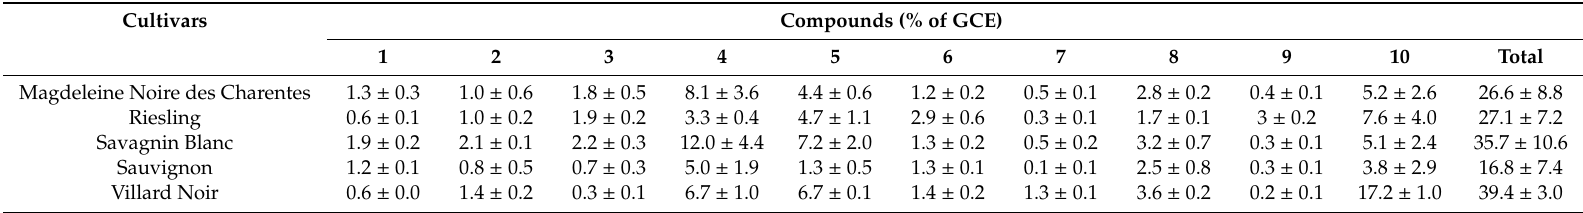
Table 1. Concentration of major polyphenols contained in grape cane extracts (GCE) from selected cultivars (% of dry GCE). (1) catechin, (2) epicatechin, (3) ampelopsin A, (4) E -piceatannol, (5) E -resveratrol, (6) hopeaphenol, (7) isohopeaphenol, (8) E - ε -viniferin, (9) E -miyabenol C, (10) E -vitisin